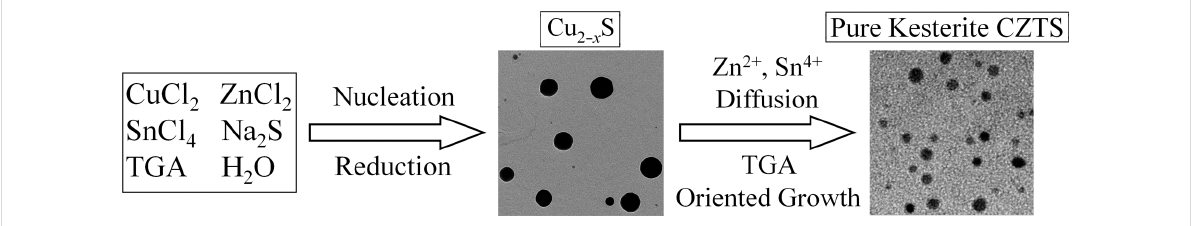
Figure 8: Schematic illustrations of the formation process for kesterite CZTS nanoparticles.